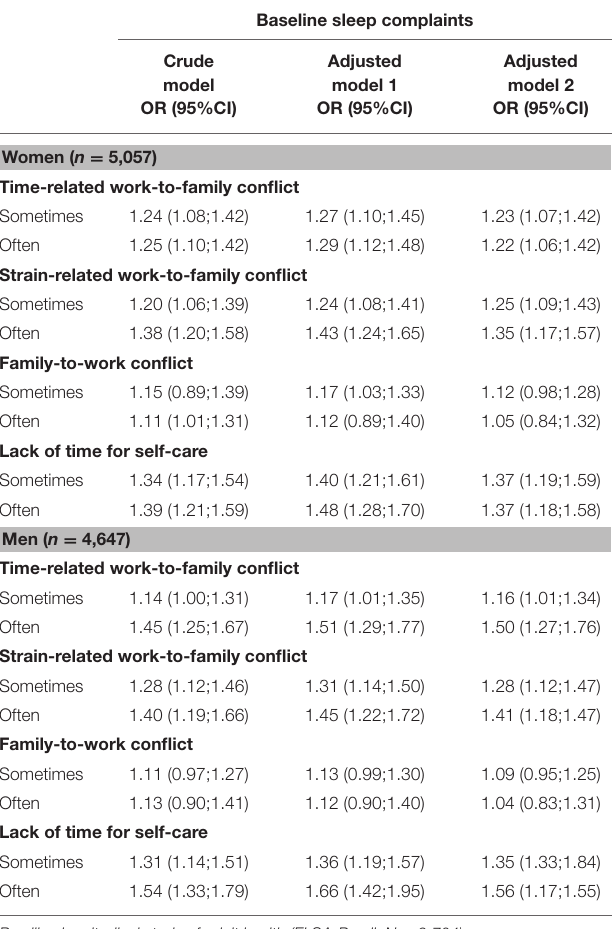
TABLE 3 | Longitudinal associations between work-family conflict, lack of time for self-care and sleep complaints over time. Sleep complaints over time Crude